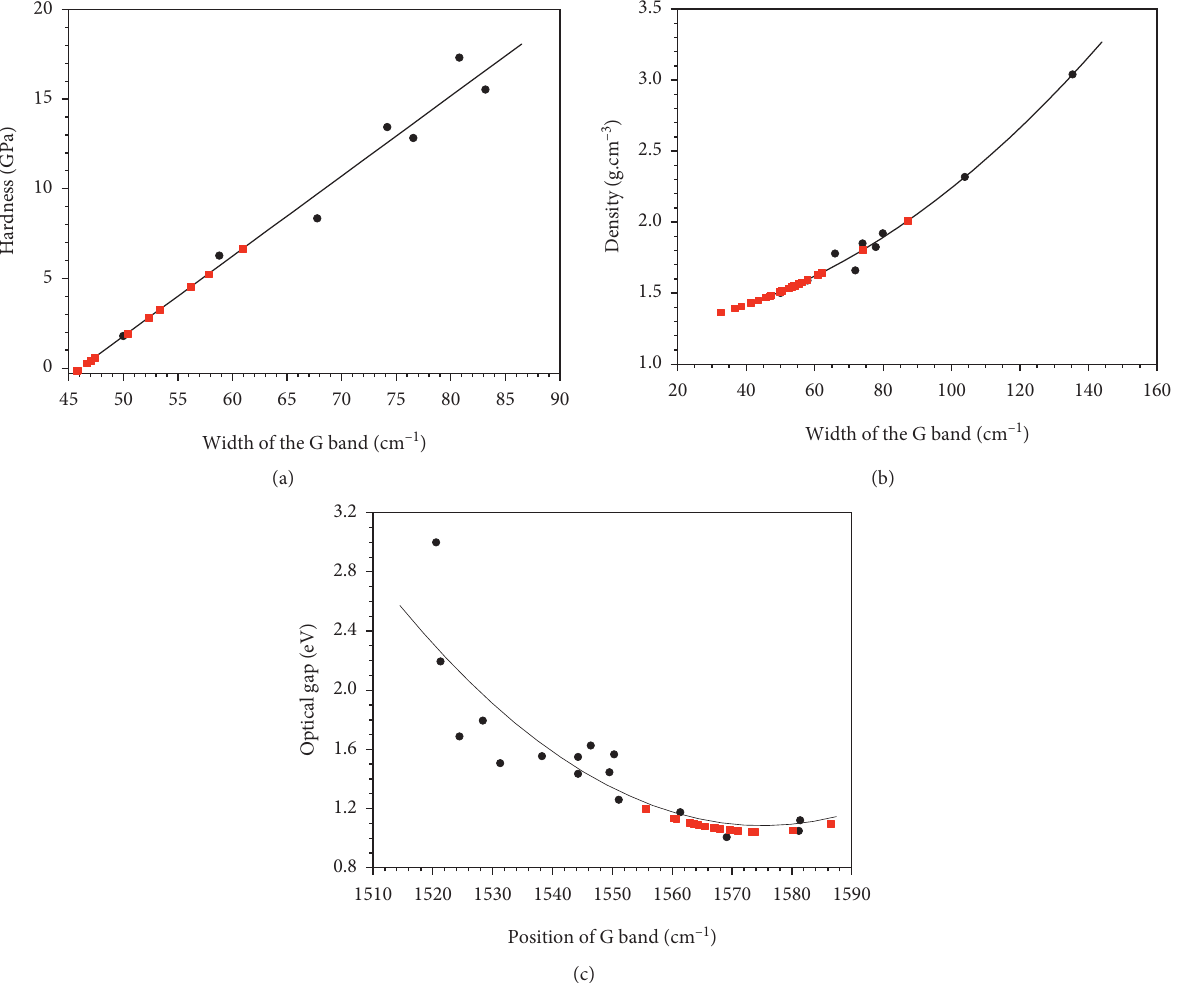
Figure 7: (a) Hardness of soot deposits as a function of G bandwidth. (b) Density of soot deposits as a function of G bandwidth. (c) Optical gap of soot deposits as a function of the Raman G band position; , this work; • , work from Tamor and Vassell